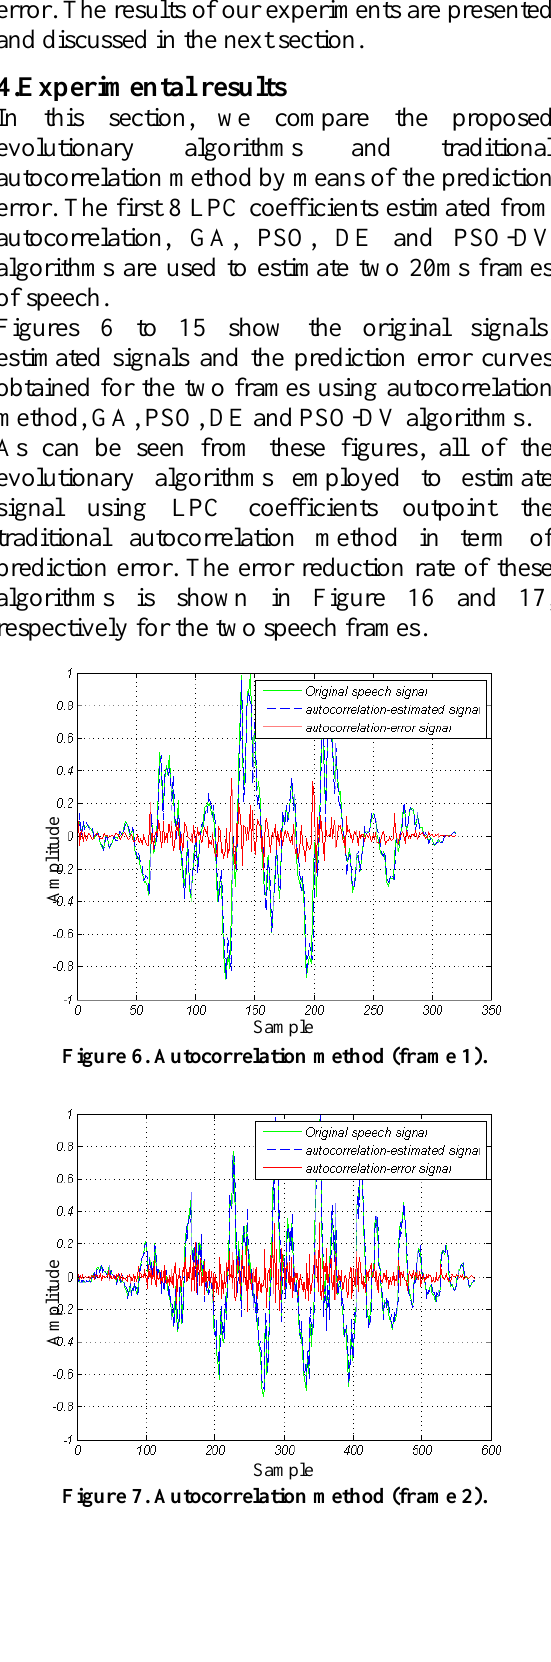
Figure 7. Autocorrelation method (frame